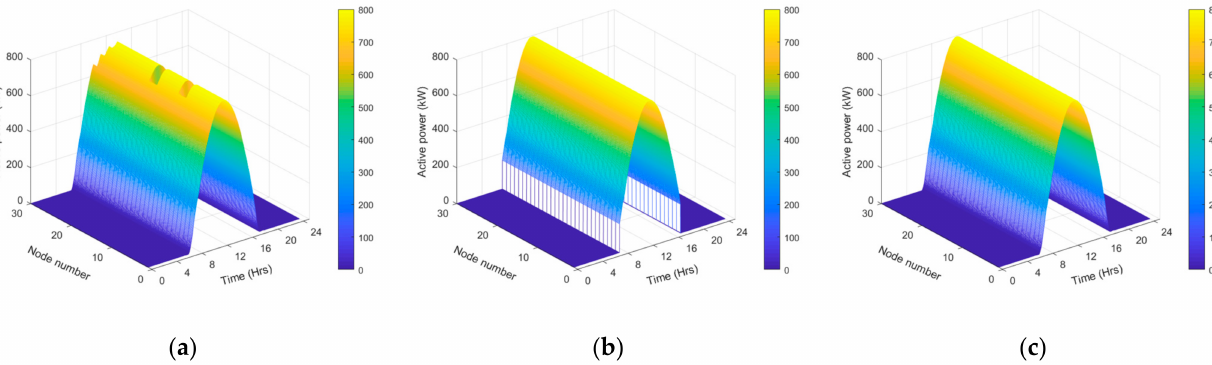
Figure 9. Daily active power generation with the ( a ) Volt–Watt, ( b ) Fixed power factor, and ( c ) Volt–Var